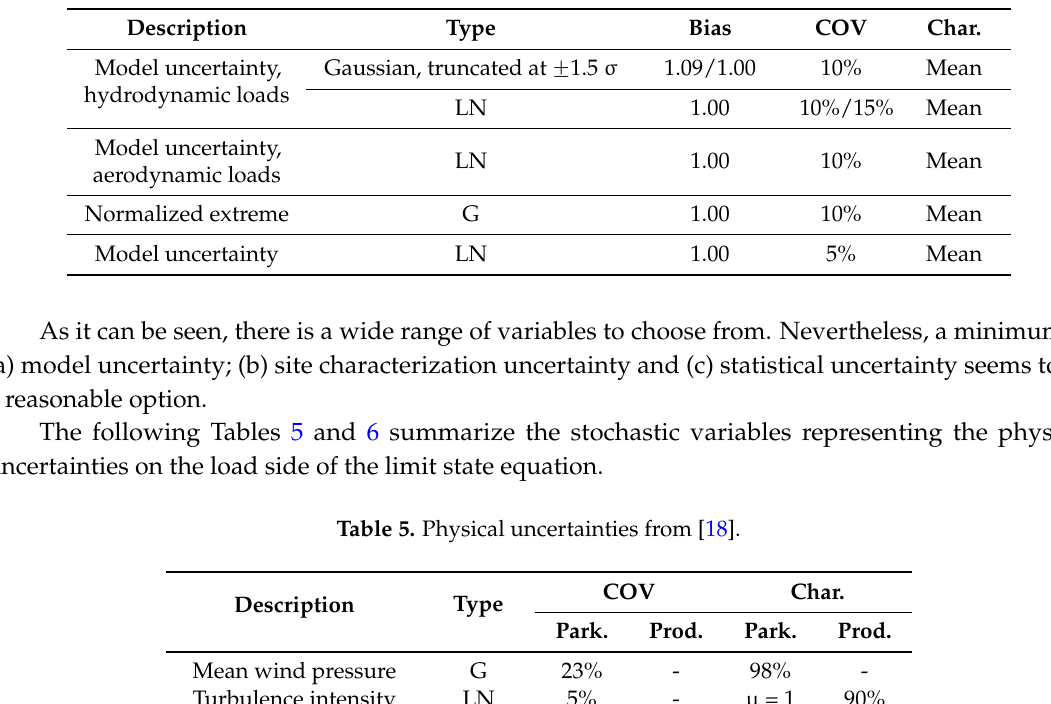
Table 4. Epistemic uncertainties from [19].